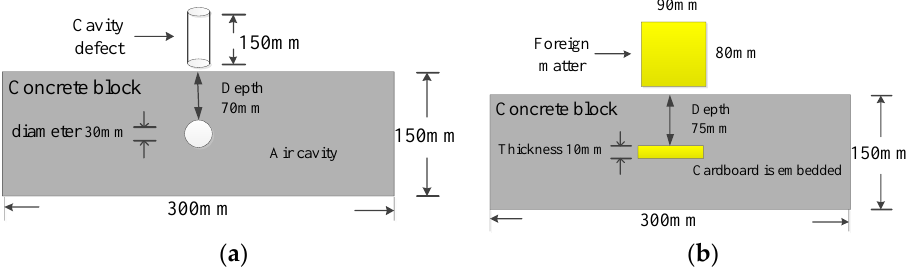
Figure 1. ( a ) Shape and embedded depth of cavity defect; ( b ) Shape and embedded depth of foreign matter defect.